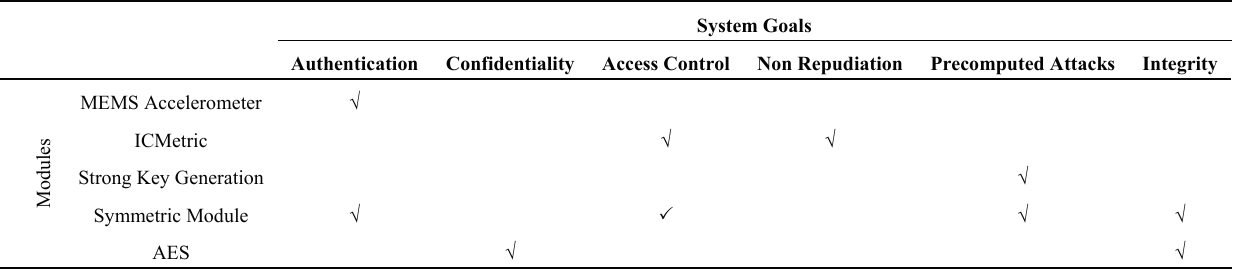
Table 4. System modules and goals